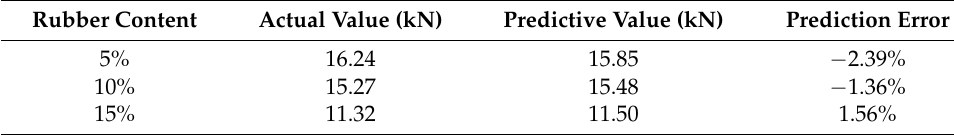
Table 4. Rise time (1) single-parameter neural network prediction results.